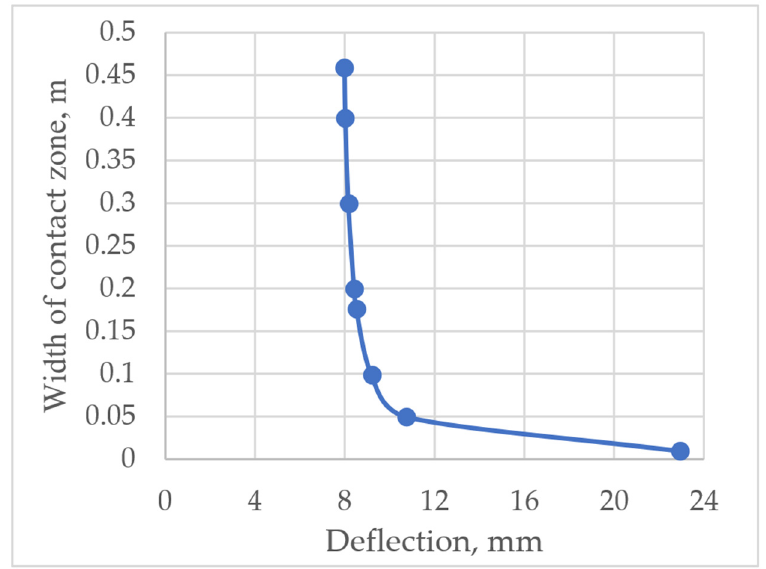
Figure 18. The influence of the width of the contact zone between the layers on the deflection of the prefabricated monolithic slab.